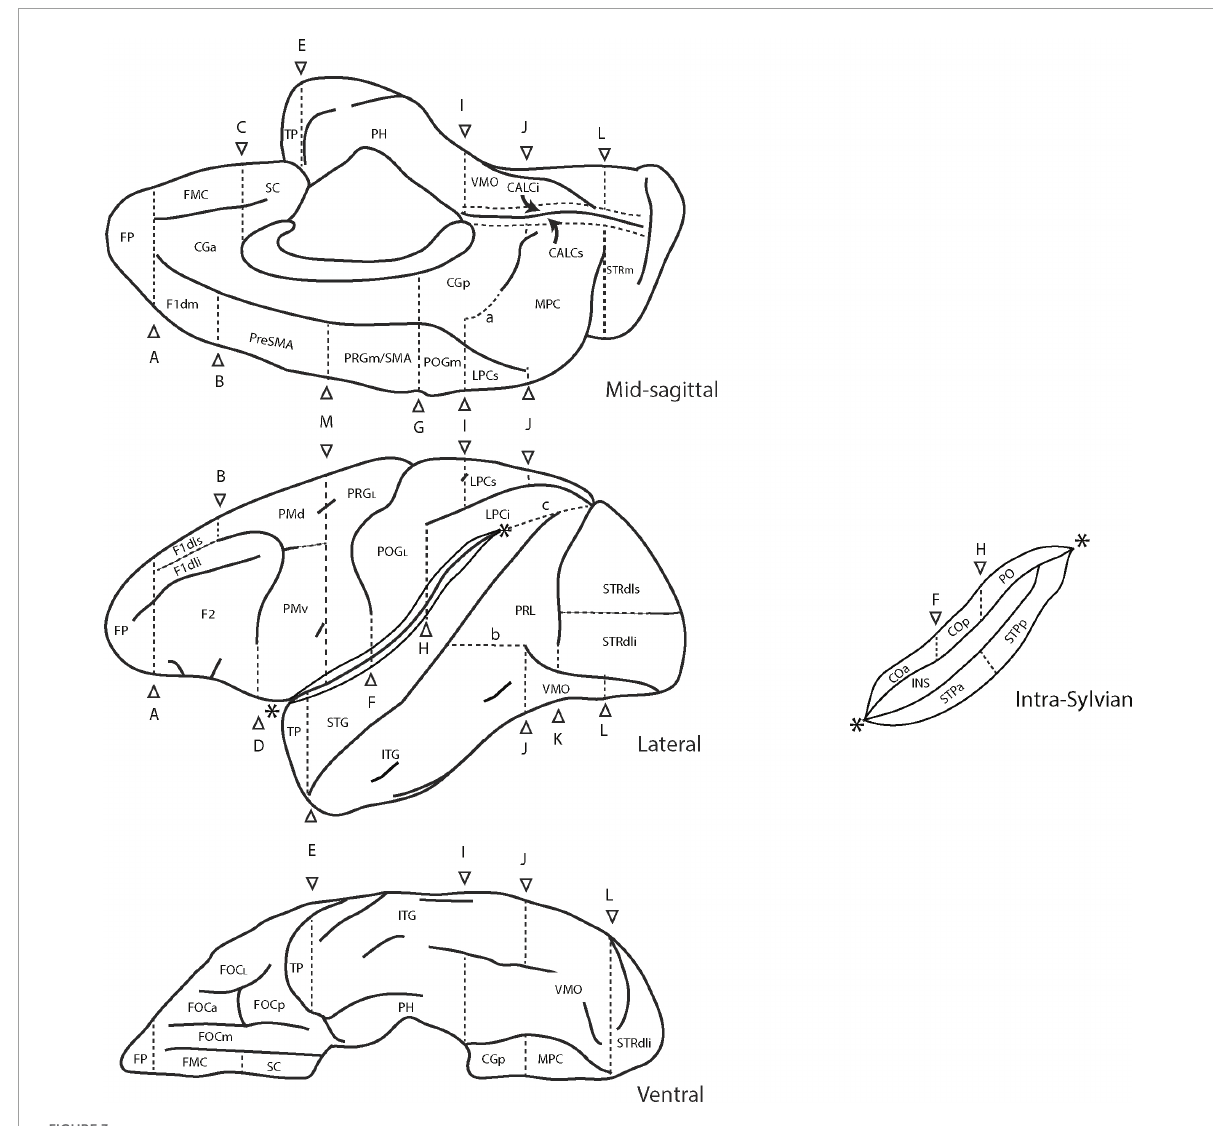
FIGURE3 Schematic diagram of the revised Harvard-Oxford Atlas parcellation of the macaque monkey brain, mHOA2.0. Sulci are depicted as solid lines and limiting planes as dotted lines. Abbreviations are listed in Table 6 . Figure modified from Rushmore et al.